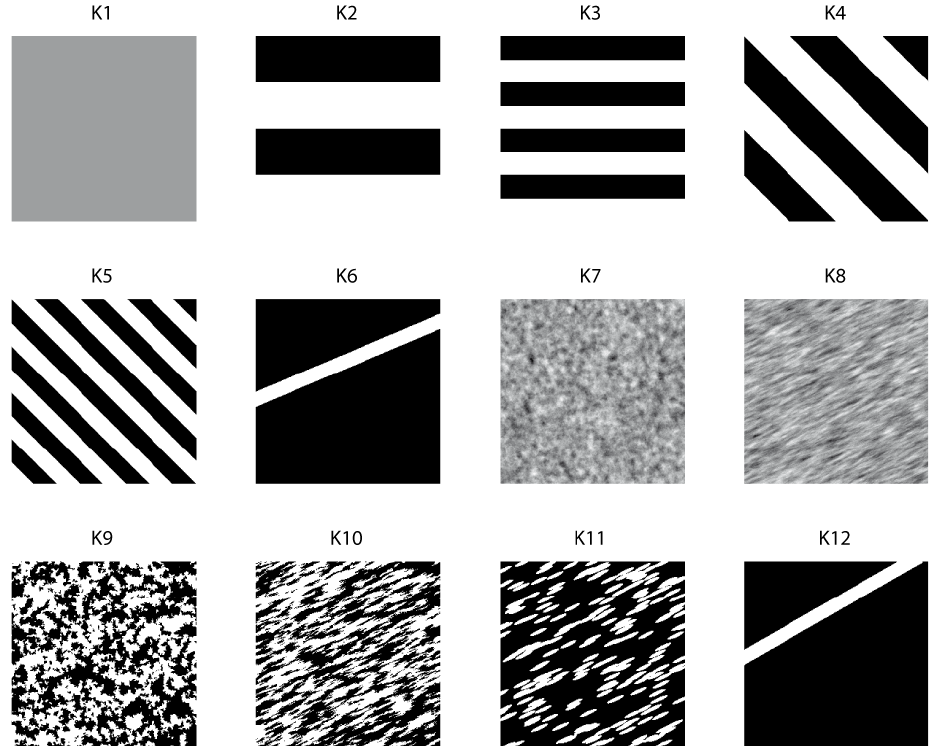
Figure 13. The twelve two-dimensional synthetic samples of porous media proposed for analysis. The white and light grays represent high conductivity values, while the black and dark grays represent low conductivities.